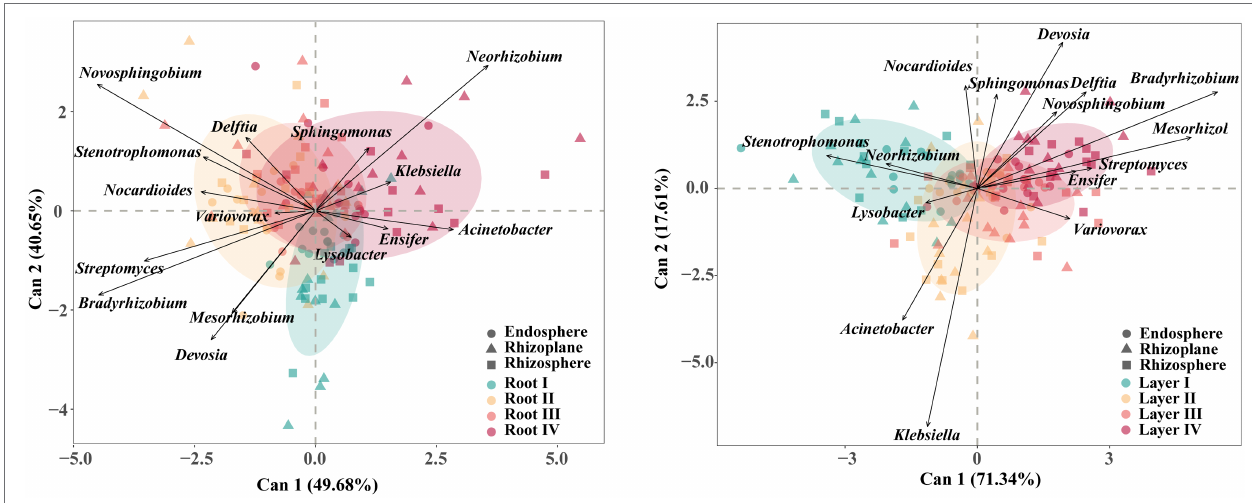
FIGURE 5 | Canonical discriminant analysis (CDA) plot based on the predominant (top 15 abundance) core bacterial taxa at genus level. Arrows represent the degree of correlation between each taxon and each root diameter or rooting depth. Circles represent the canonical group means and 85% confidence interval for each root